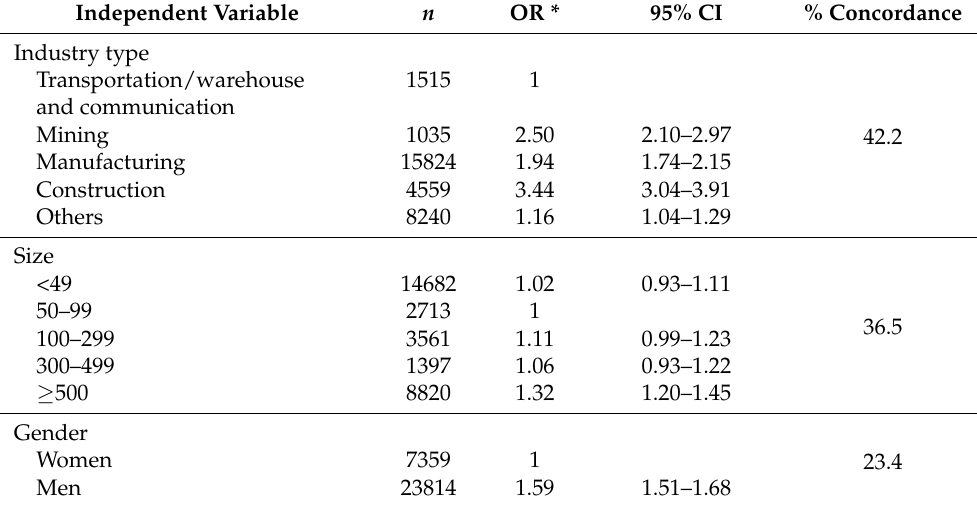
Table 2. Results of logistic regression